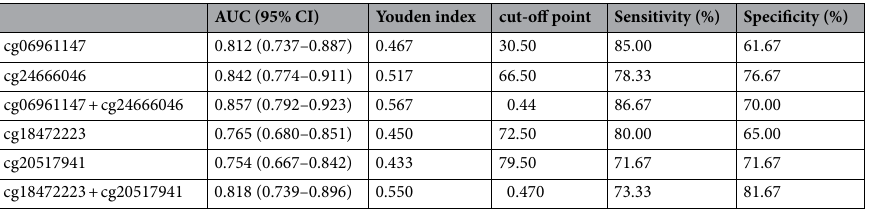
Table 3. The ROC curve parameters of four differentially methylated locus and their combinations for discriminating between ADLI and non-ADLI.